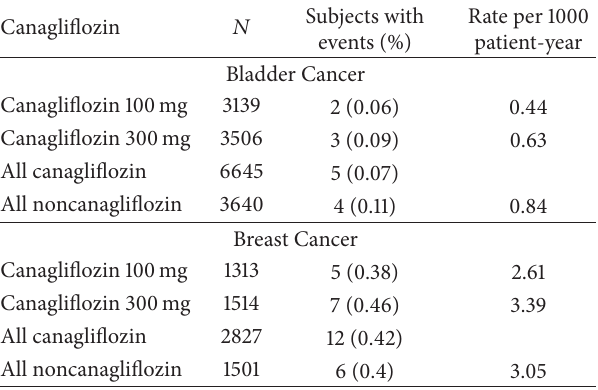
Table 3: Incidence rates of bladder and breast cancer with canagli- flozin